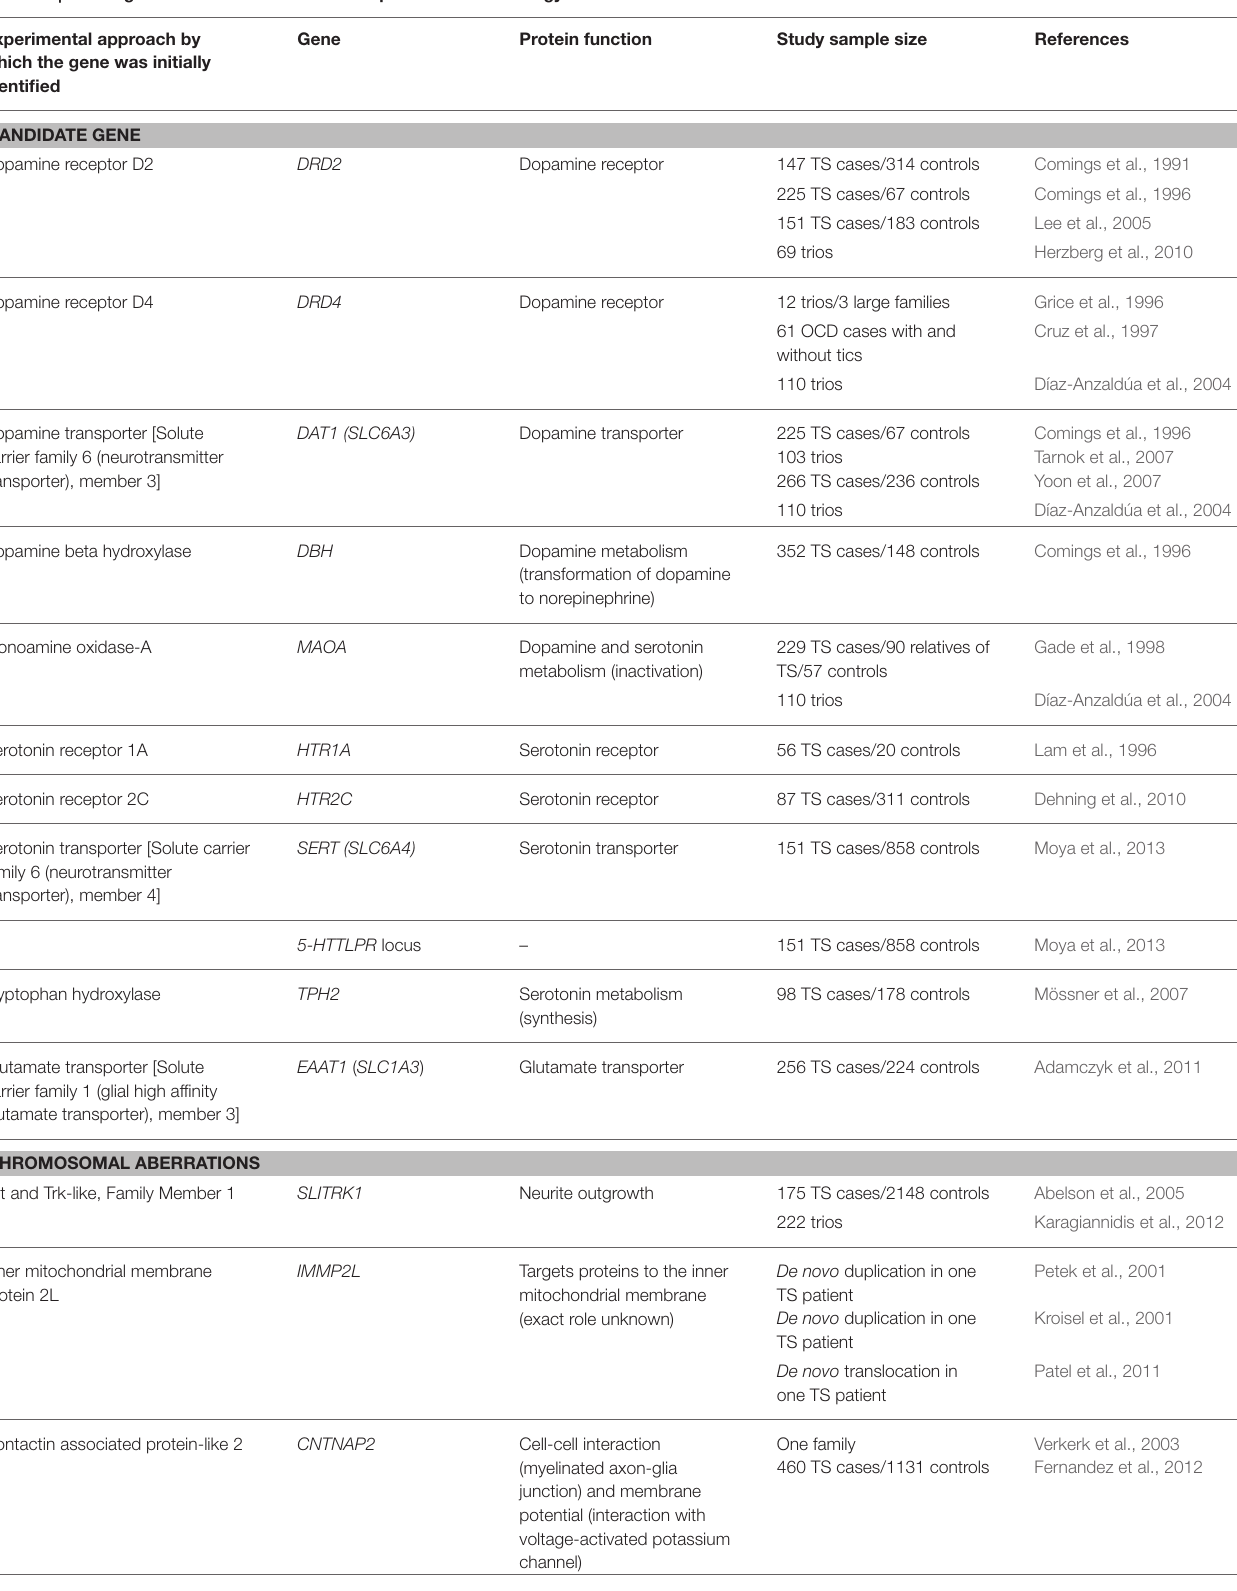
TABLE 1 | List of genes that have so far been implicated in TS etiology. Experimental approach by which the gene was